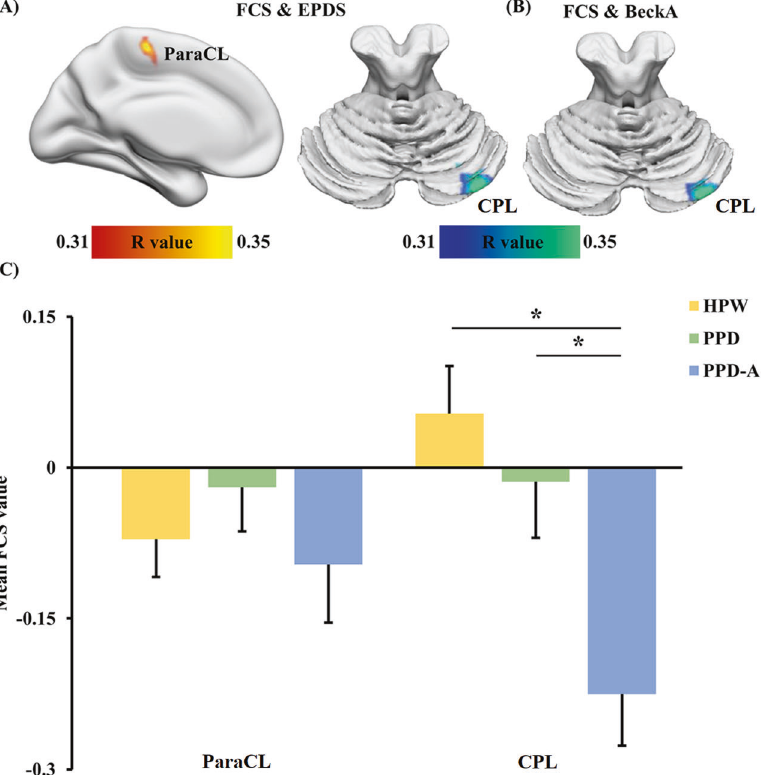
Fig. 2 Whole brain voxel-wise correlation analyses were used to identify the associations between FCS and Edinburgh Postnatal Depression Scale (EPDS) and Beck ’ s Anxiety Inventory (BAI) scores. A There is a signi fi cant positive correlation between FCS in paracentral lobule (ParaCL), and signi fi cant negative correlation between FCS in right cerebellem posterior lobe (CPL), and EPDS, respectively. B There is also a signi fi cant negative correlation between FCS in right CPL and BAI. C Post-hoc two sample t-tests showed that FCS was signi fi cantly lower in right CPL in both PPD and PPD-A patients compared to HPW. There was no signi fi cant difference in FCS between PPD and PPD-A patients in these or in any other brain regions.